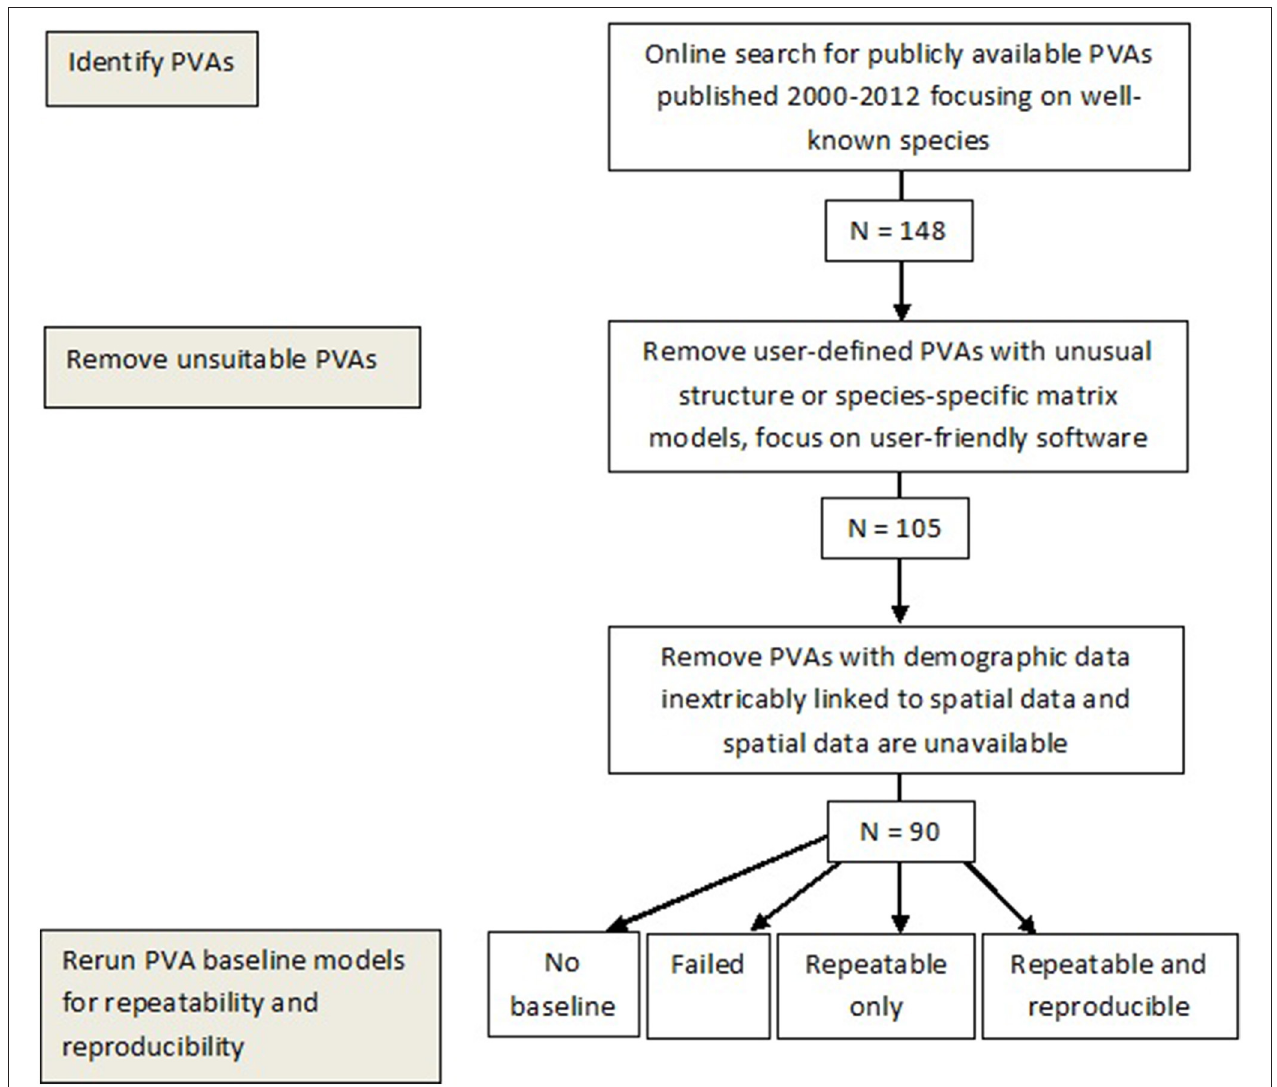
FIGURE 1 | Summary of methodology used to select Population Viability Analysis (PVA) models and determine repeatability and reproducibility of